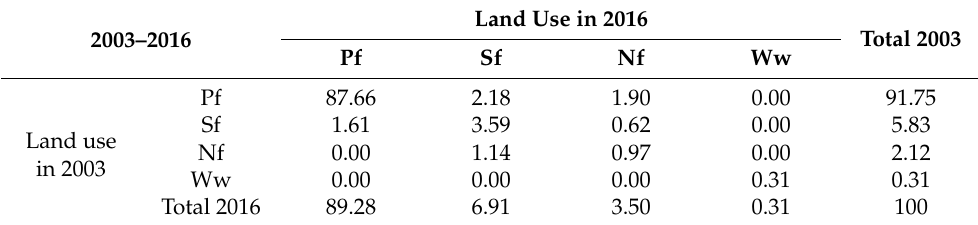
Table 6. Matrix of transitions between 2003 and 2016.